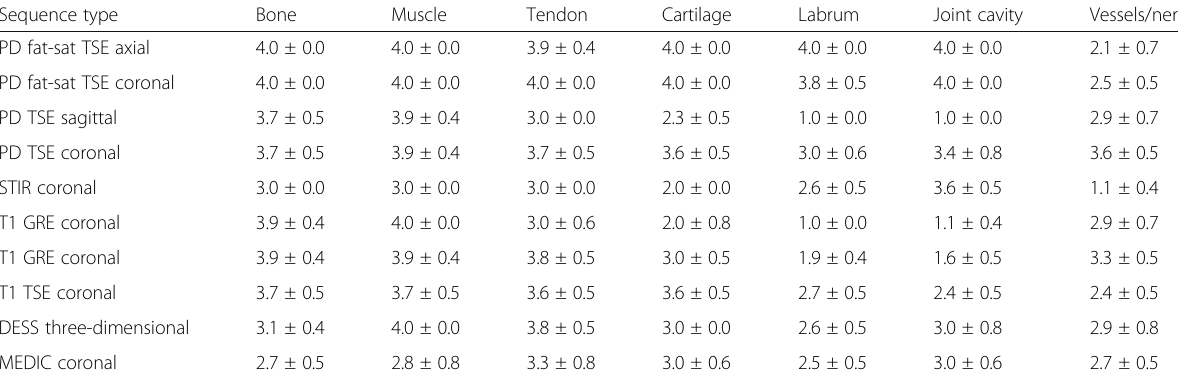
Table 3 Structure